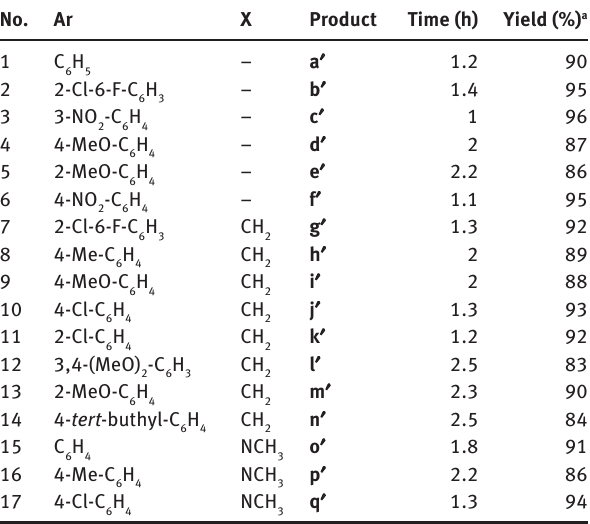
Table 2: Synthesis of α , α′ -bis (substituted-benzylidene) cyclo- alkanone derivatives.